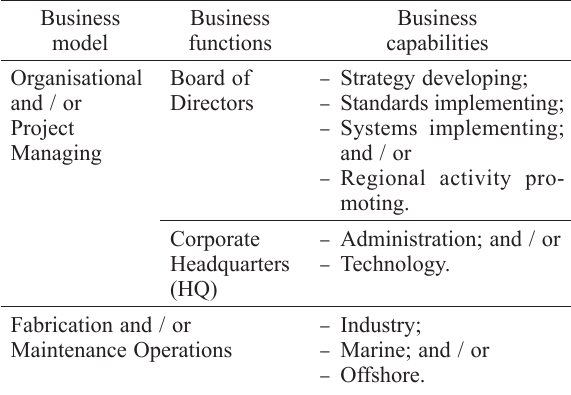
Table 2. Matrix of organisation one business functions and